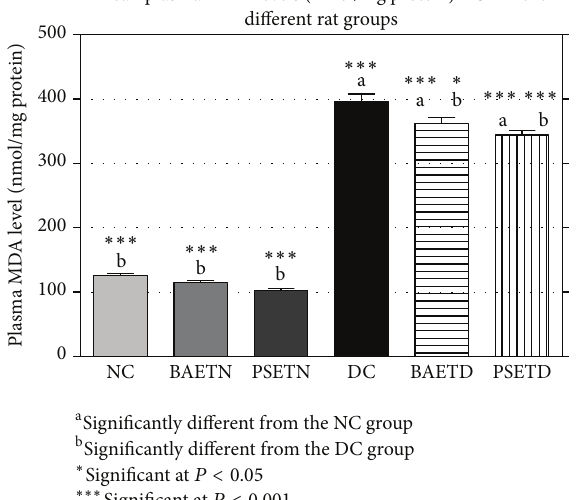
a Significantly different from the NC group b Significantly different from the DC group ∗∗∗ Significant at P < 0.001 Figure 7: Effects of Balanites aegyptiaca fruits and Petroselinum sativum leaf aqueous extracts on the mean pancreas weight (gm/100gm of BW) in normal and STZ-induced diabetic rats (mean ± SE). Mean size of pancreatic islets ( 𝜇 m) ± SE in the different rat groups